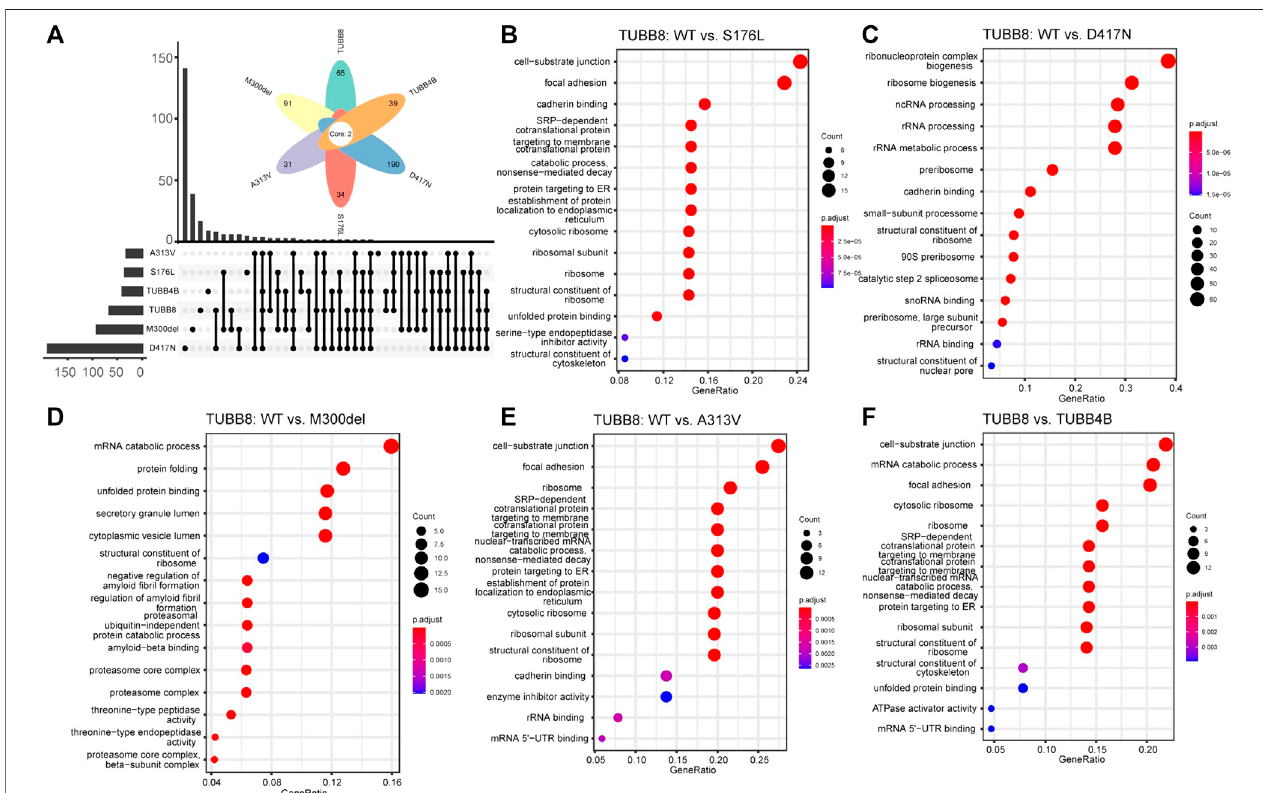
FIGURE5 | GO enrichment analysis ofWT and mutant TUBB8. (A) Amountsof unique and common proteins between each group. (B) GO enrichmentanalysisof differently expressed proteins between TUBB8 WT and S176L. (C) GO enrichment analysis of differently expressed proteins between TUBB8 WT and D417N. (D) GO enrichment analysis of differently expressed proteins between TUBB8 WT and M300del. (E) GO enrichment analysis of differently expressed proteins between TUBB8 WT and A313V. (F) GO enrichment analysis of differently expressed proteins between TUBB8 and